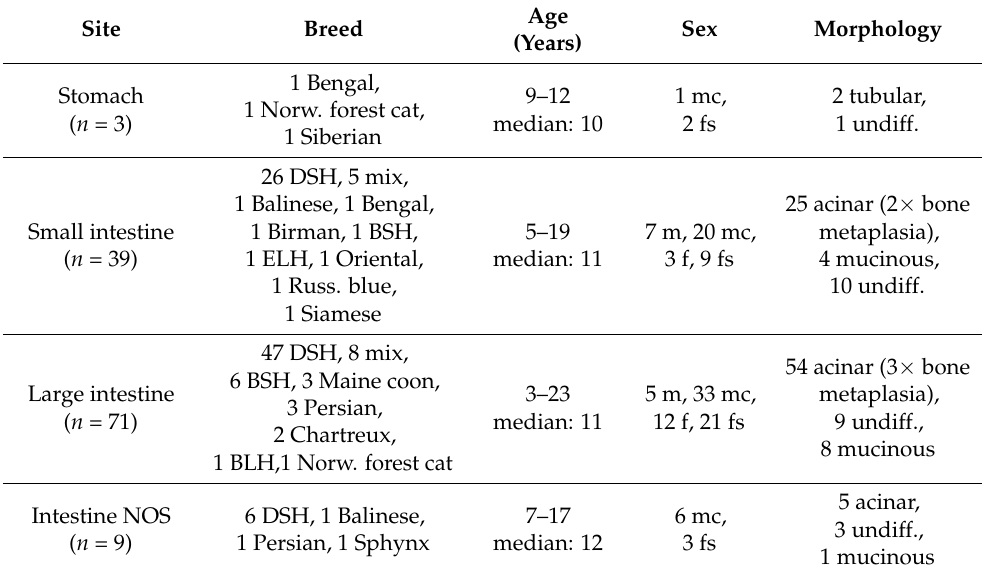
Table 4. Signalment of the cats with gastrointestinal carcinoma in the present study ( n = 122).